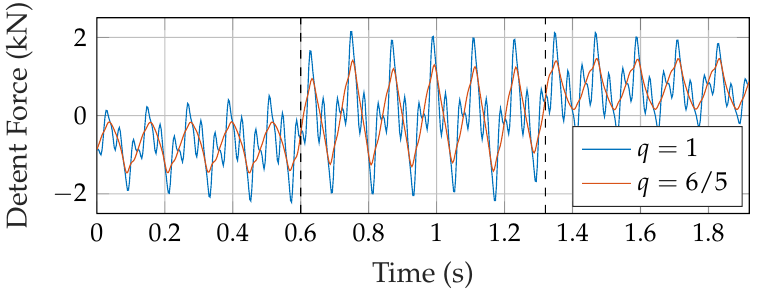
. The stroke length allows for 5